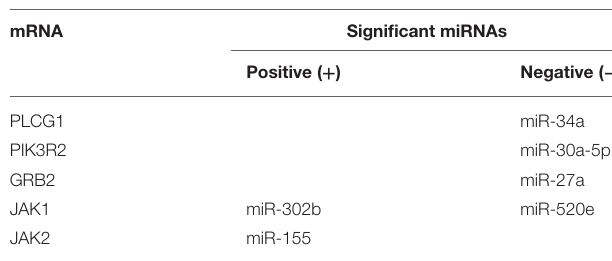
TABLE 2 | Significant miRNAs targeting the shared downstream molecules ( p <